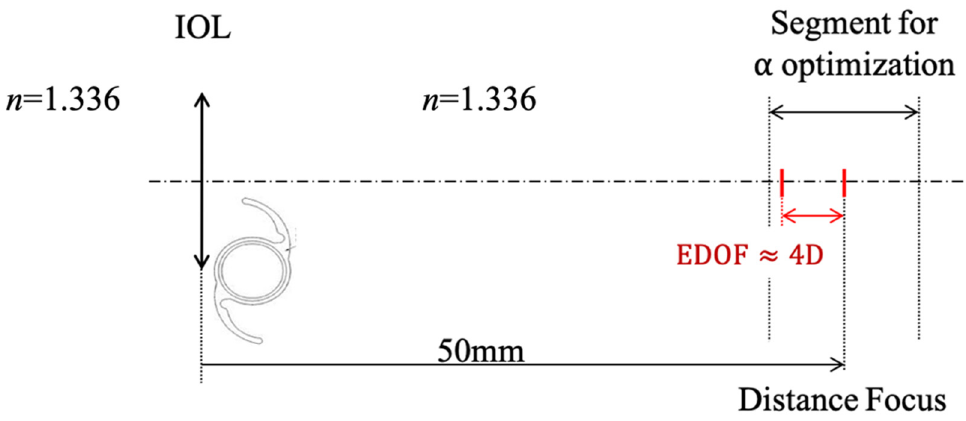
Figure 9. Exemplary case of application: EDOF